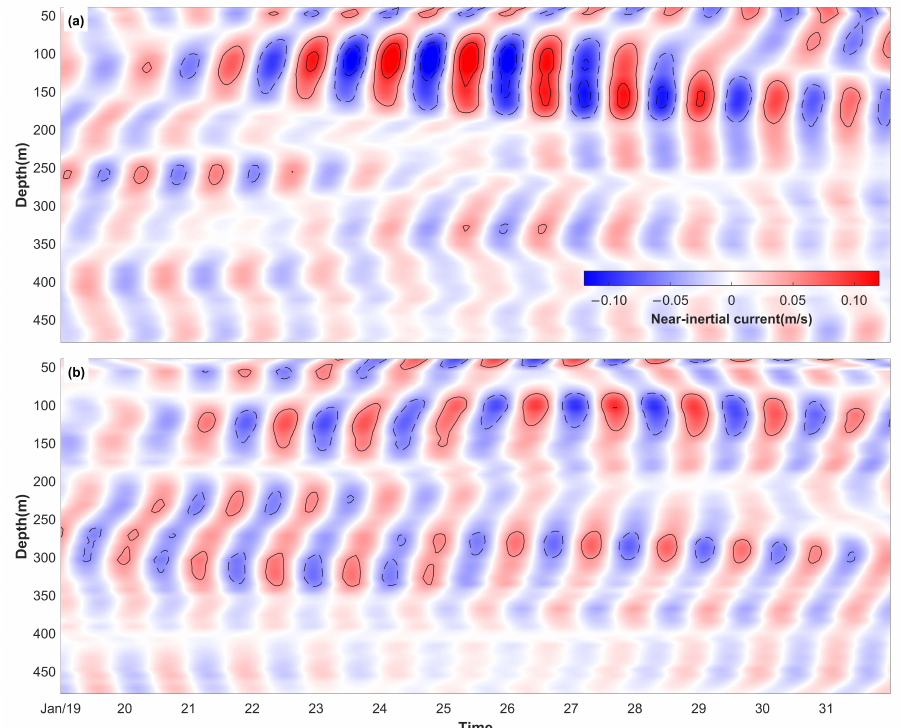
Figure 17. Zonal ( a ) and meridional ( b ) near-inertial currents in January 2018. The contours start at ± 0.05 m/s with a stride of 0.05